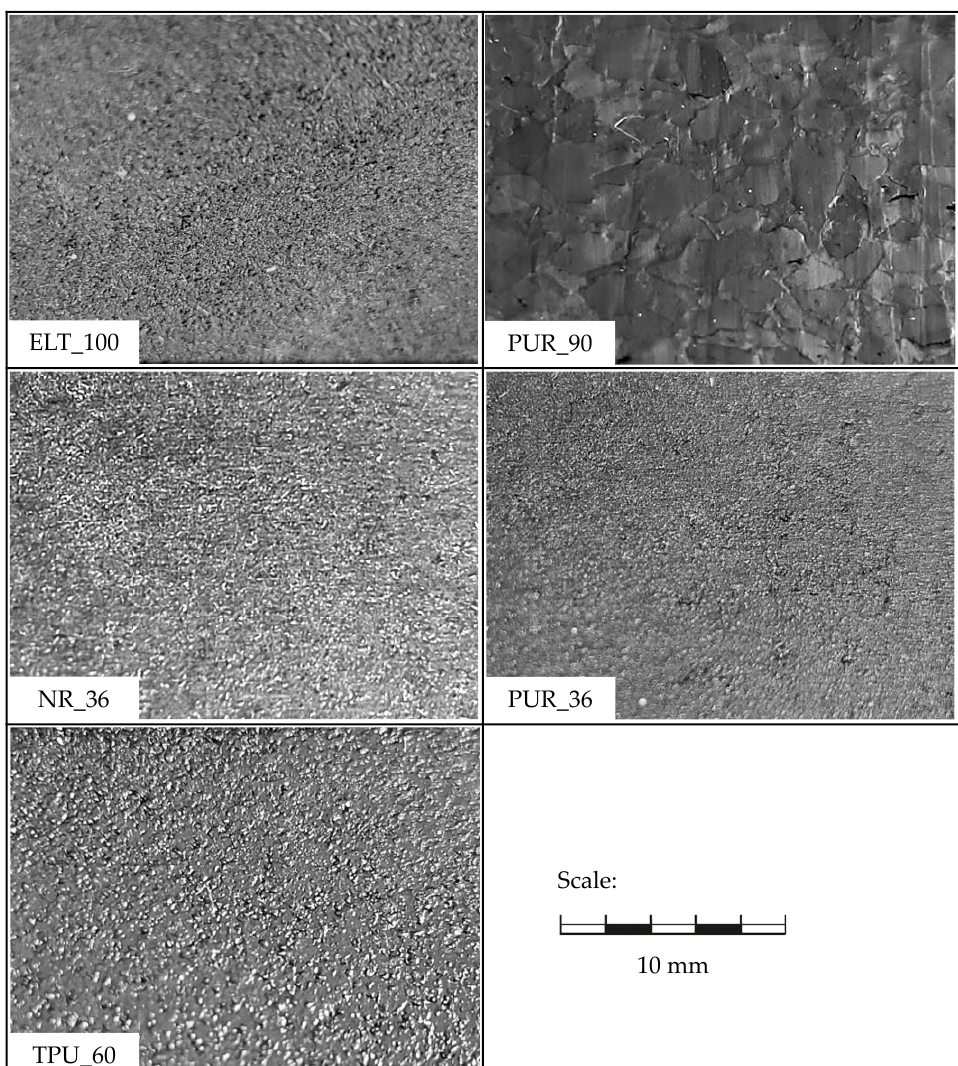
Figure 6. Comparison of the surface structures of the test specimens.